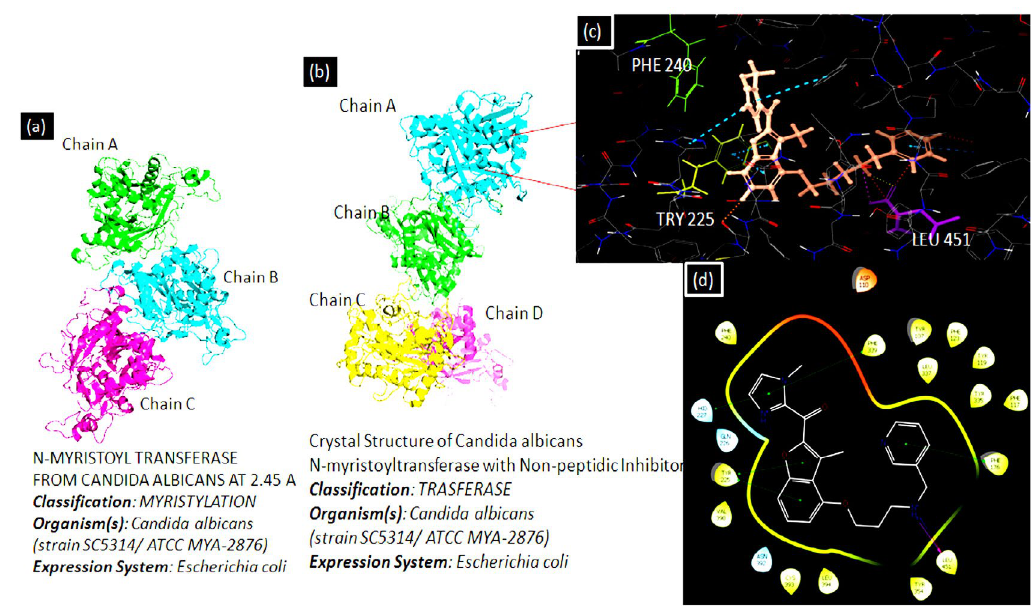
Fig. 3. PDB ID [1NMT] represents NMT from Candida albicans species at 2.45Ao and PDB ID [1IYL] represents Candida albicans NMT with Non-peptidic Inhibitor. The Ligplot interaction diagram has been generated using the Schrodinger software suit. The ligand is showing its major interaction with a certain amino acid such as PHE 240, TRY 225, and LEU 451.